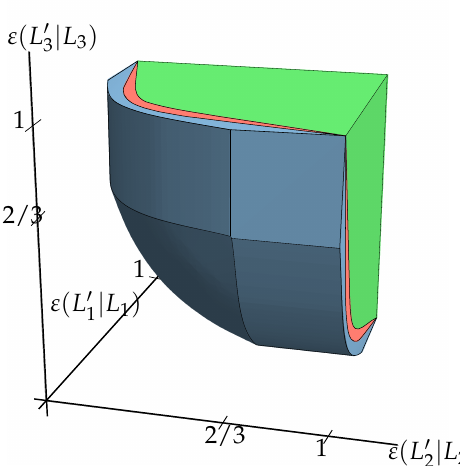
Figure 2. Uncertainty regions for three reference observables, namely the angular momentum components L 1 , L 2 , L 3 for spin 1, each with outcome set X = {− 1,0, + 1 } and the choice c ( x , y ) = ( x − y ) 2 for the cost function. The three regions indicated correspond to the different overall figures of merit ε M ( A (cid:48) | A ) ≥ ε C ( A (cid:48) | A ) ≥ ε E ( A (cid:48) | A ) described in Section